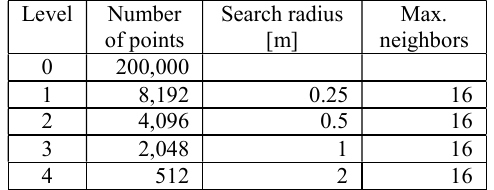
Table 5. Number of points per PointNet++-Level, search radii and neighbor